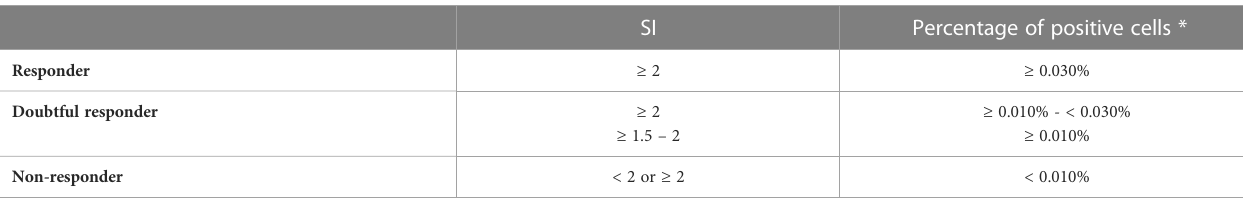
TABLE 2 Criteria to de fi ne responders and doubtful responders to Bp